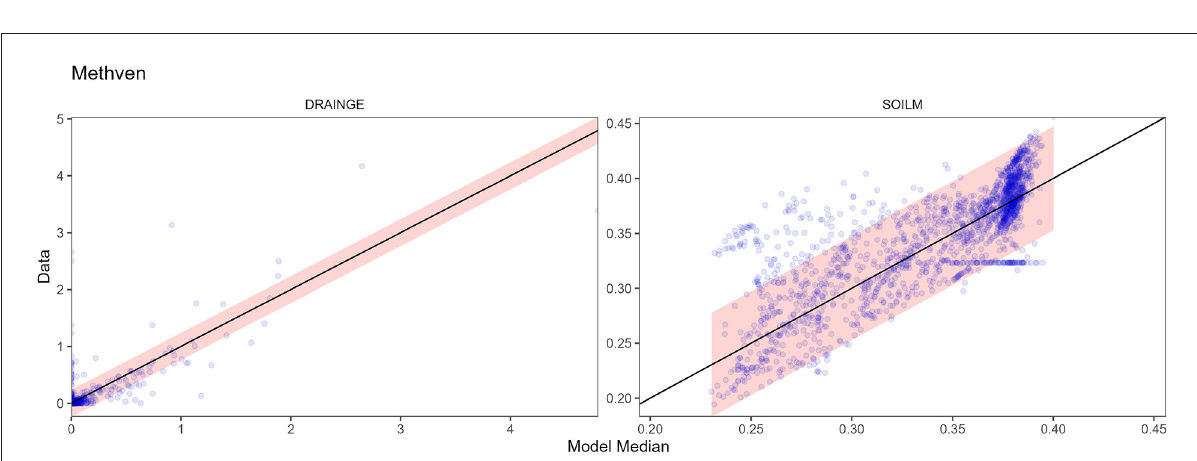
FIGURE7 Calibration to Methven soil water content and drainage data. X -axis shows the median of the model predictions for 10,000 realizations at each time step. The shaded area is the 95% region for the residuals. Units: SOILM (m 3 /m 3 ), DRAINGE (m/d).